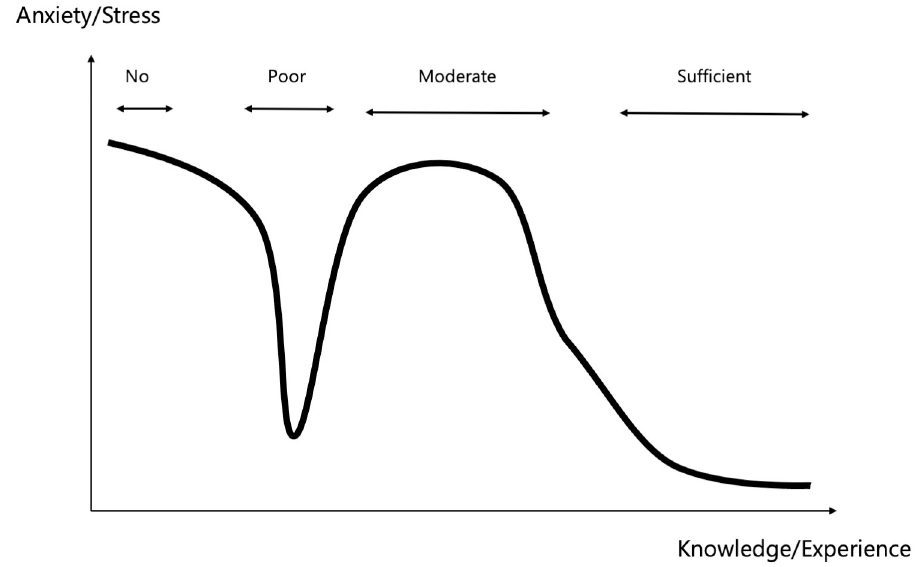
Fig 4. Diagrammatic image of the association between knowledge and anxiety/stress in radiation emergency medicine. People without knowledge/experience (no knowledge/experience) have high anxiety/stress levels, which decreases after gaining minimal knowledge/experience (poor knowledge/experience). As they gain more knowledge/ experience (moderate knowledge/experience), their anxiety/stress levels increase. As they acquire more knowledge/ experience (sufficient knowledge/experience), their anxiety/stress levels will decrease according to the amount of knowledge/experience.